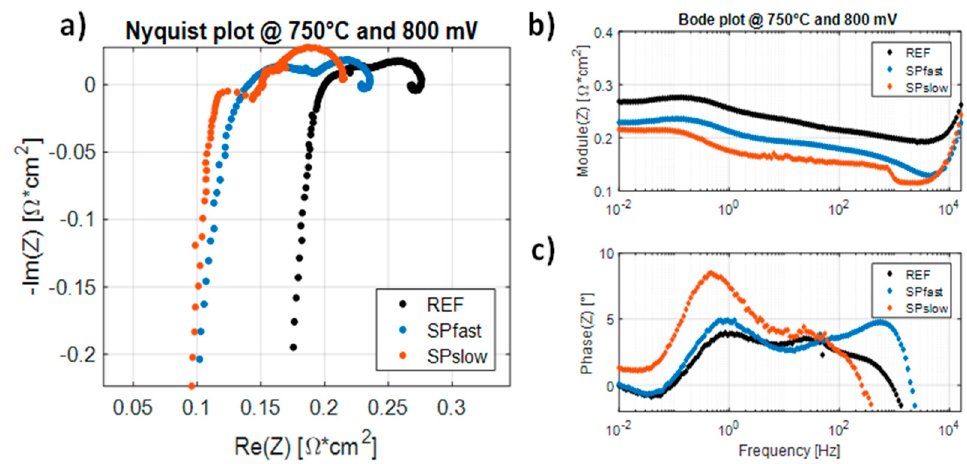
Figure 8. Nyquist ( a ) and Bode ( b , c ) plots of samples REF (black markers), SPfast (blue markers), and SPslow (red markers) measured at 750 °C and 800 mV.